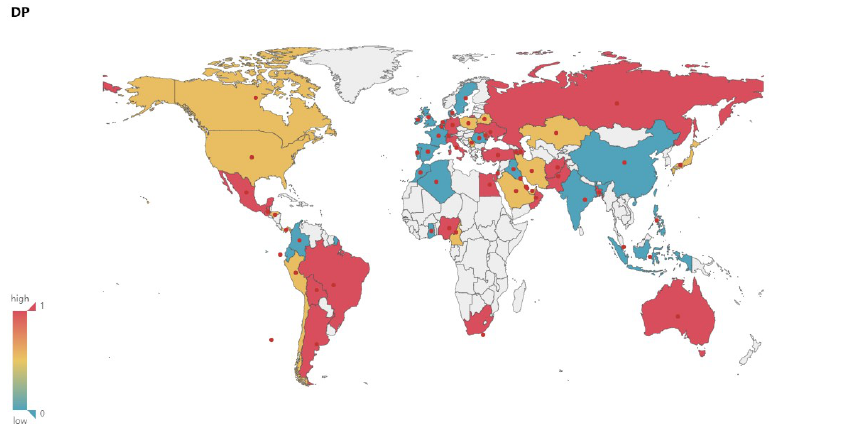
Figure 5. Correlation between New and